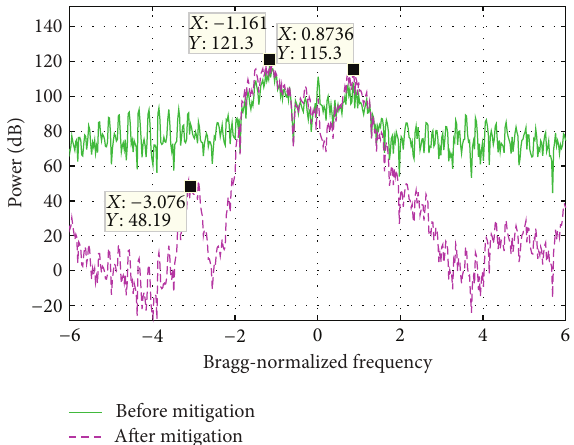
Figure 15: Echo power spectrum density of two range bins.